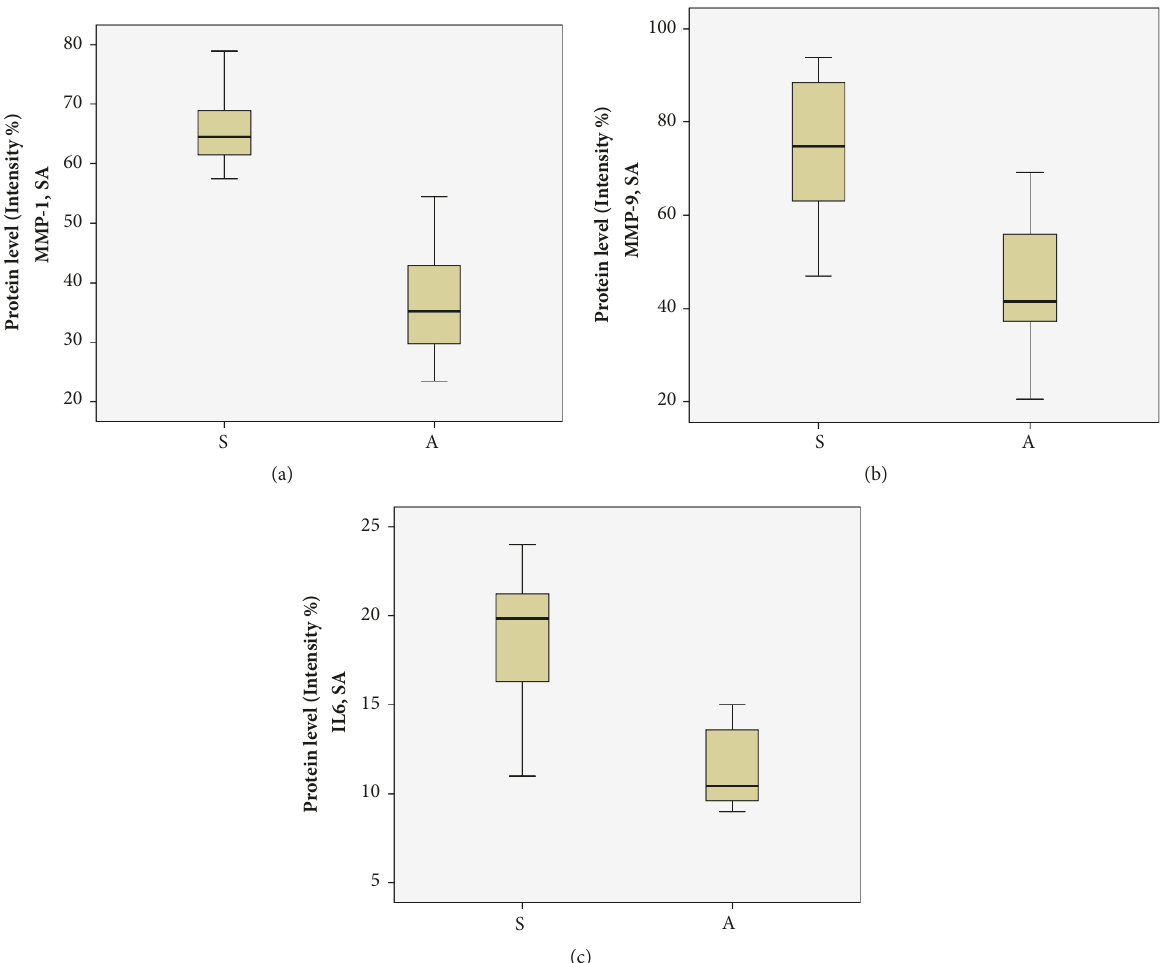
Figure 4: Boxplot depiction of differences in MMP-1 (a), (MMP-9) (b) and IL-6 (c) values between symptomatic and asymptomatic patients